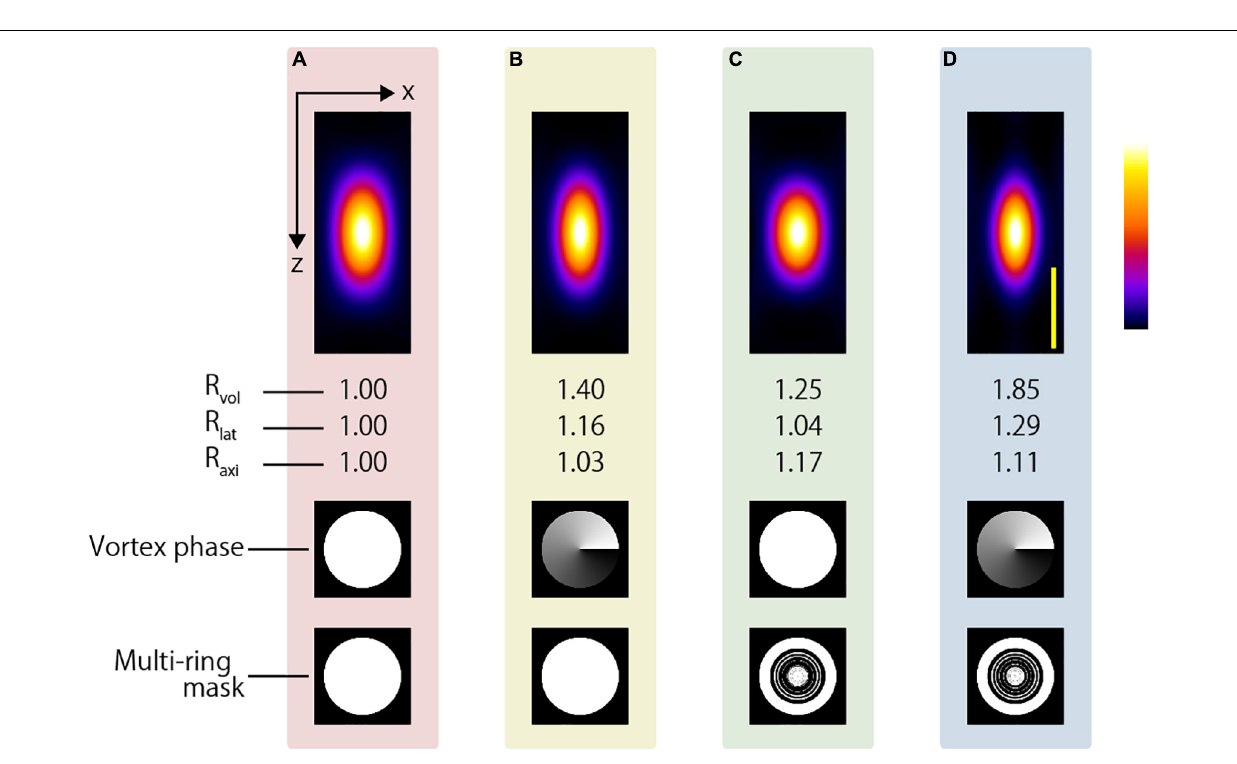
Frontiers in Neuroscience |